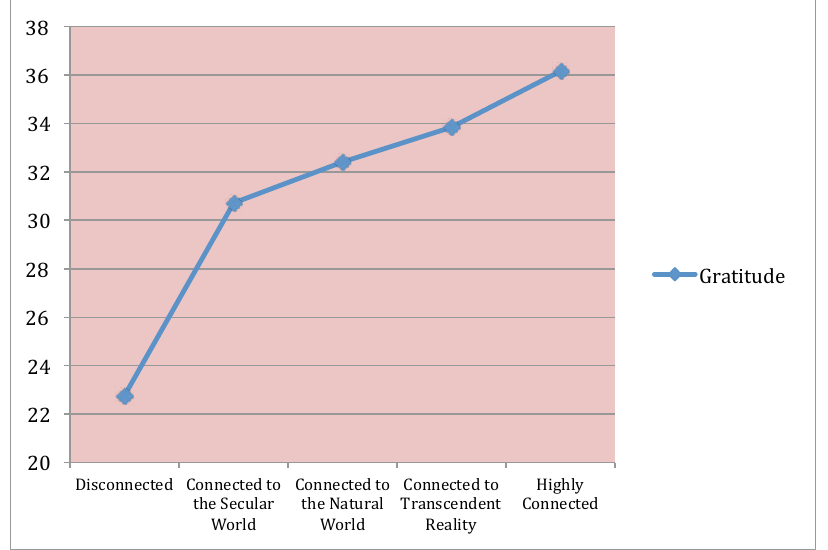
Figure 4. One-way ANOVA of mean depression across five classes of spiritual connection, F=4.22*. * p < .01.